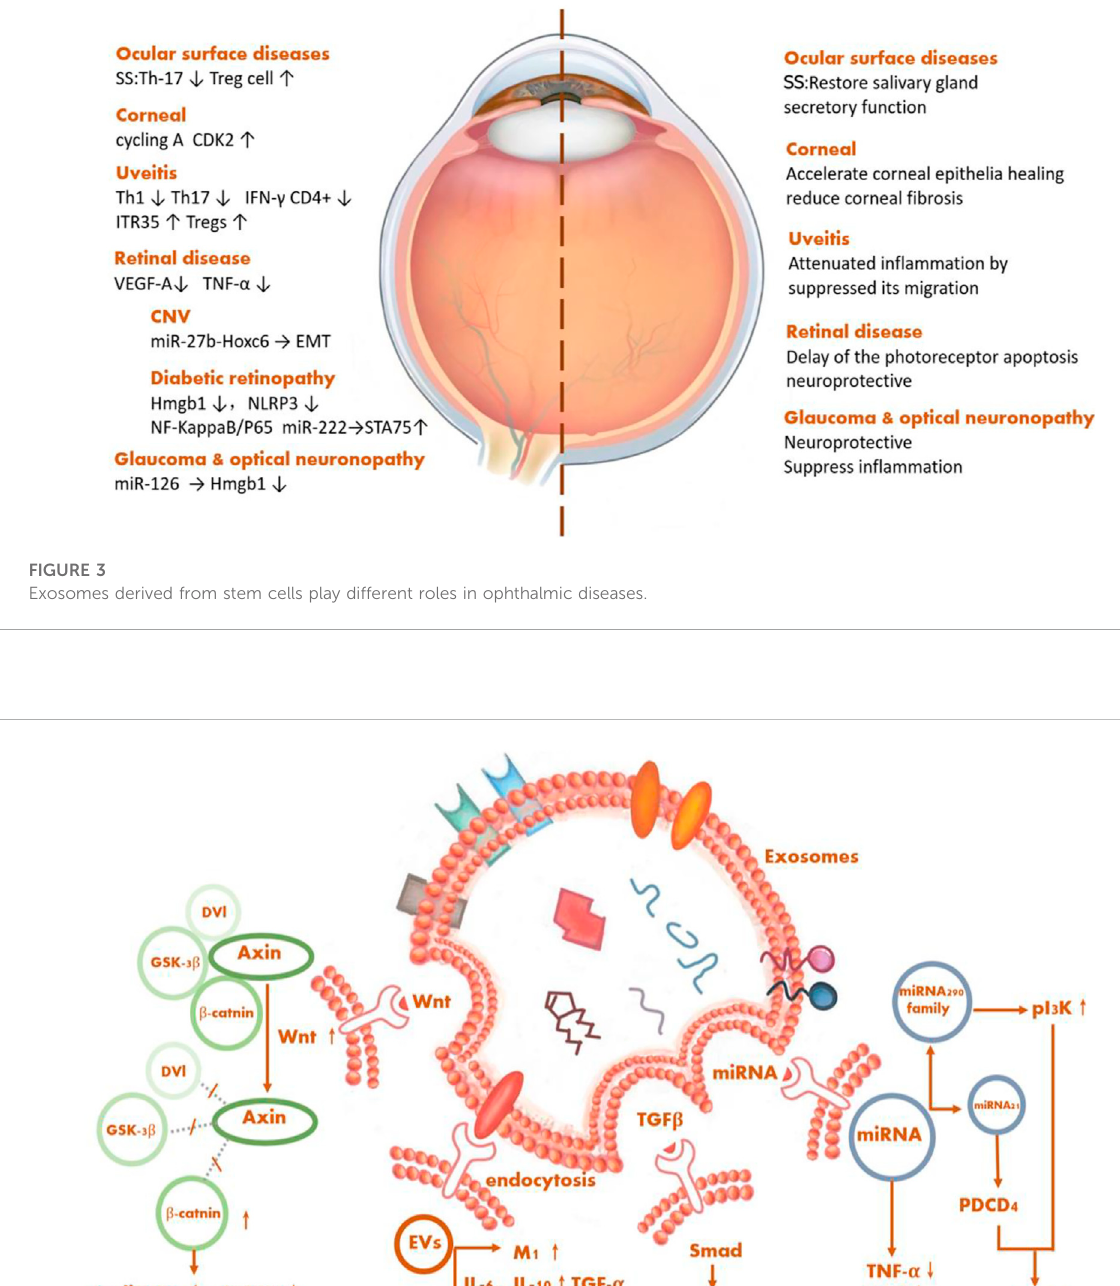
Frontiers in Bioengineering and